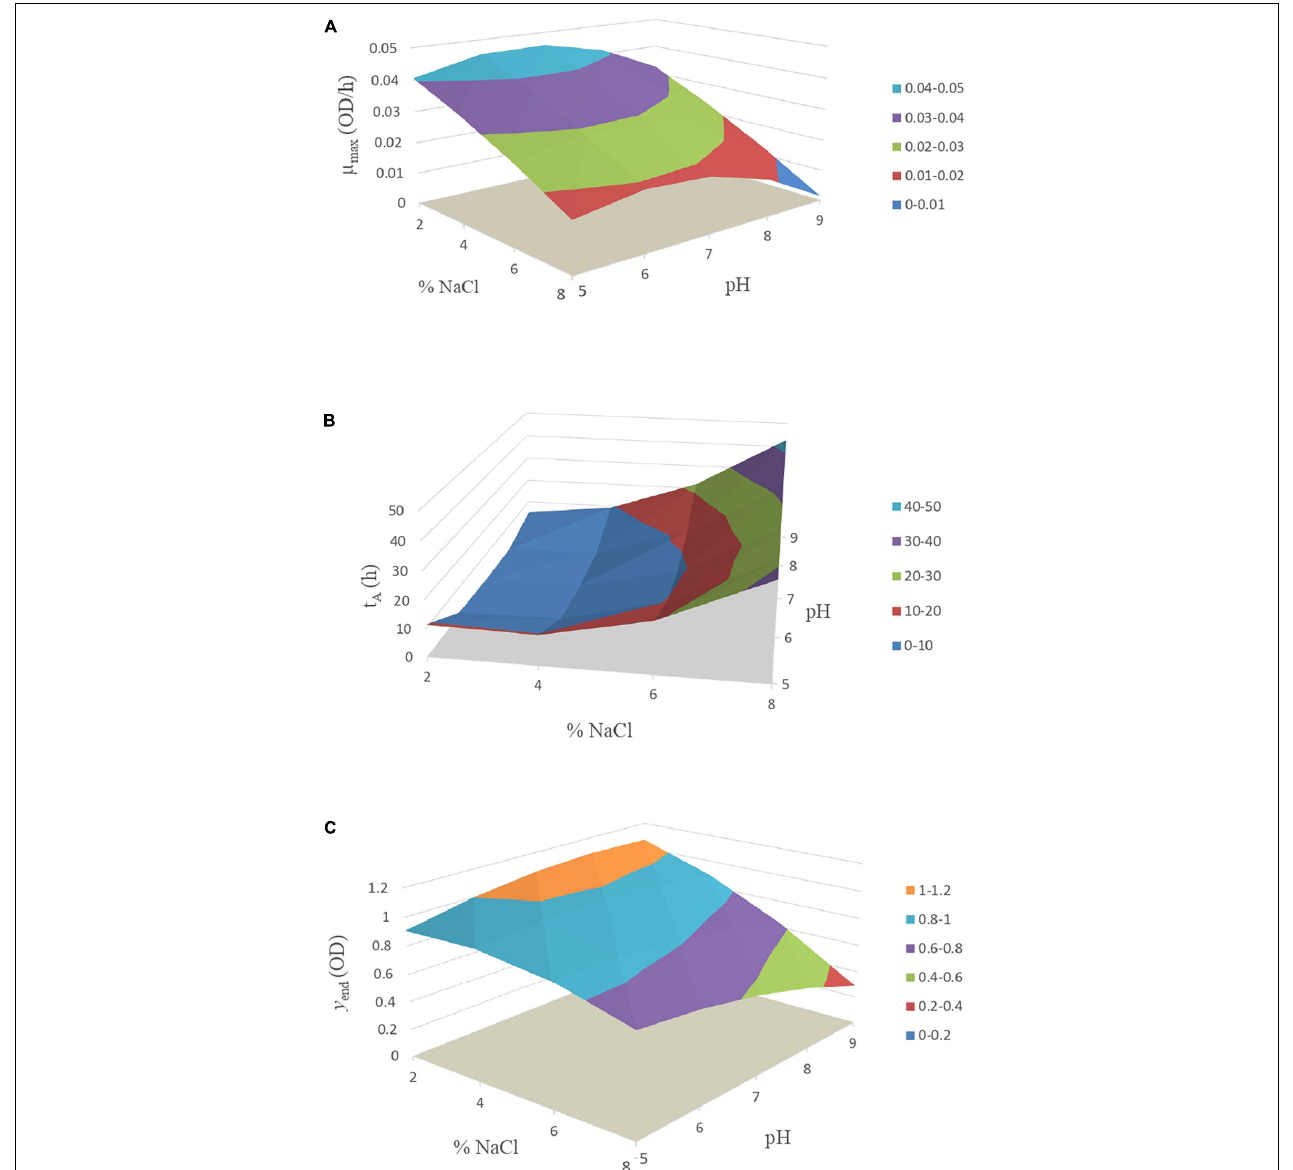
FIGURE 2 | Response surface model of Vibrio spp. for kinetic parameter (A) µ max , (B) t A and (C) y end .